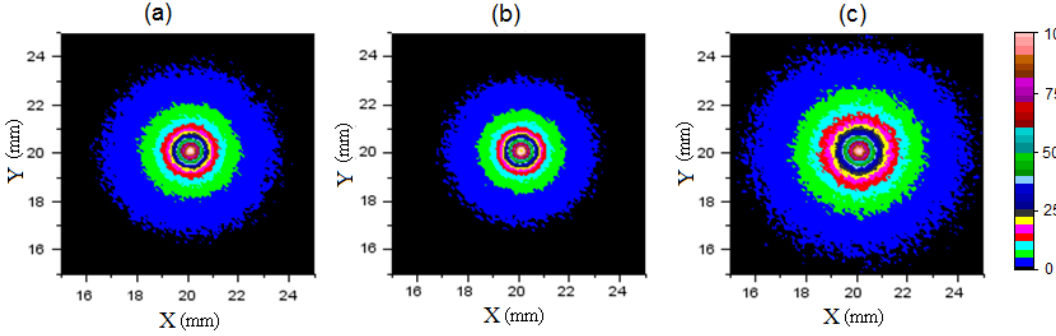
Figure 5. Simulated backscattering images captured over the curved boundary of a whole apple covered by a skin layer of thickness 150 µm with different optical properties. The data were generated with µ a ( f ) = 0.0075 mm −1 - µ ’ s (f) = 1.25 mm −1 , ( a ) µ a ( s ) = 0.05 mm −1 - µ ’ s ( s ) = 4 mm −1 , ( b ) µ a ( s ) = 0.5 mm −1 - µ ’ s ( s ) = 4 mm −1 , ( c ) µ a p s q = 0.05 mm ´ 1 - µ ’ s ( s ) = 2.5 mm ´ 1 , r s = 35 mm, and normalized with respect to their peak intensity.